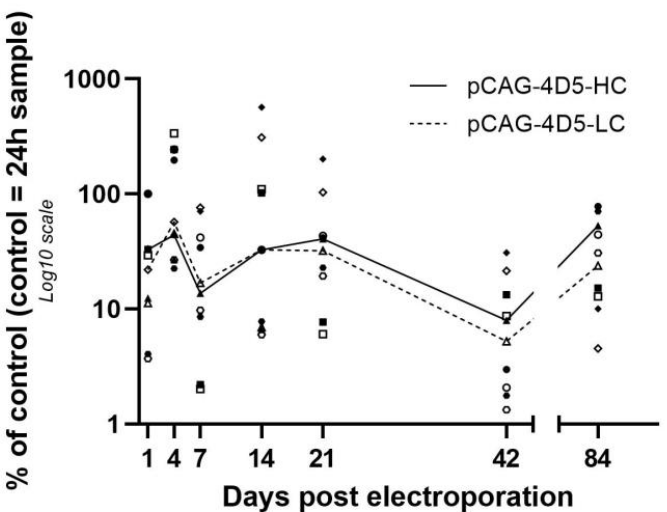
pCAG-4D5-HC, dashed line: pCAG-4D5-LC) ( n = 5, five mice per time point).